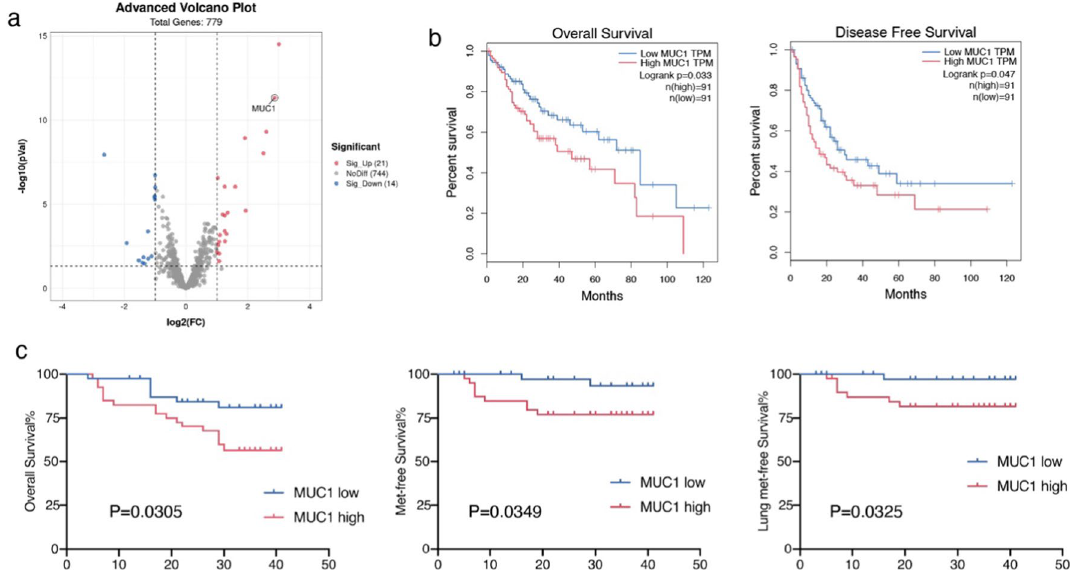
Fig. 1 MUC1 associates with a worse clinical outcome. a Volcano plots of differential gene expression in 31 patients with paired primary tumors and lung metastases. Blue and red dots represent downregulated and upregulated genes, respectively. b MUC1 expression analysis of Overall survival and progress free interval of MUC1 high group and MUC1 low group from LIHC of The Cancer Genome Atlas (TCGA). c MUC1 expression analysis of Overall survival, met-free survival and lung met-free survival in a liver cancer cohort from Shanghai Renji Hos- pital (n = 80). *P < 0.05, **P < 0.01, ***P < 0.001, by log rank